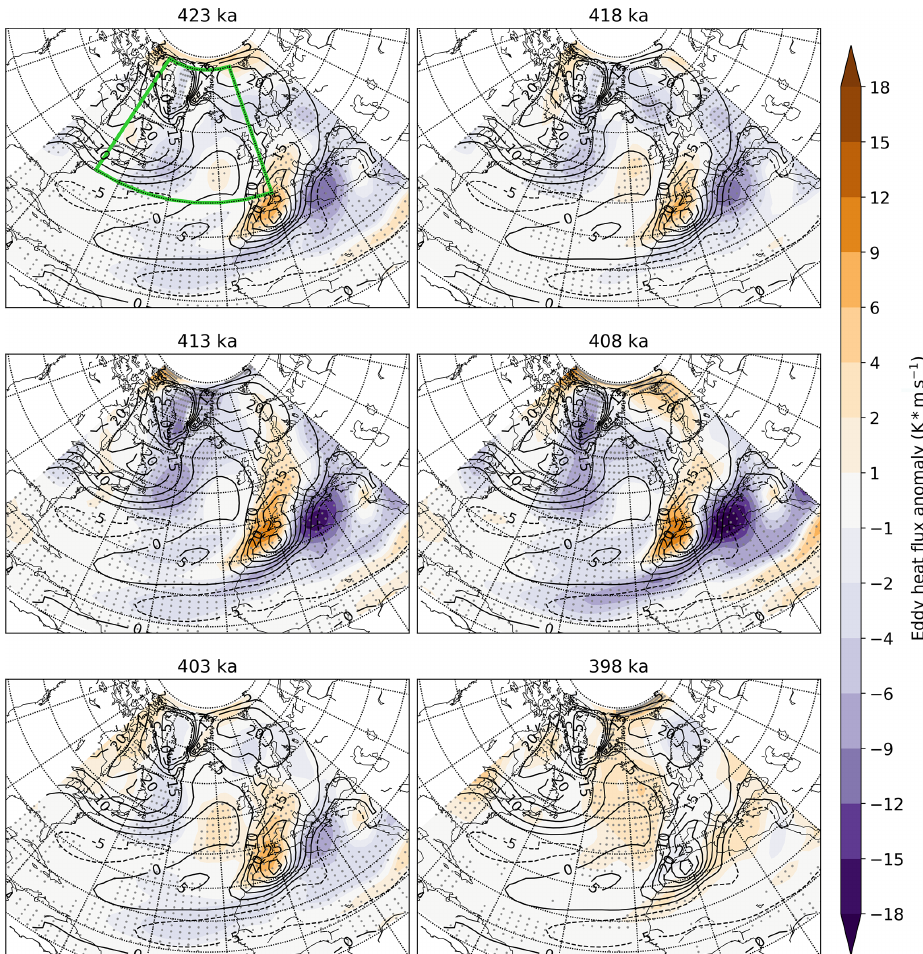
Figure 3. Mean lower-tropospheric (700hPa) total eddy heat flux anomalies over the North Atlantic. Black contour values indicate the mean JJA total eddy heat flux from the final century of the piCtrl run (baseline climatology). Shaded values shown are boreal summer mean anomalies over the final 100 years of each designated simulation, stippled where the difference is statistically significant at the 95% level. The green box in the 423ka panel shows the area (40–80 ◦ N, 290–0 ◦ E) over which area-mean values are computed for correlations in Figs. 4 and